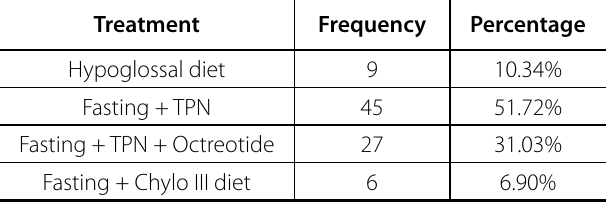
Table 2. Used treatment frequency.